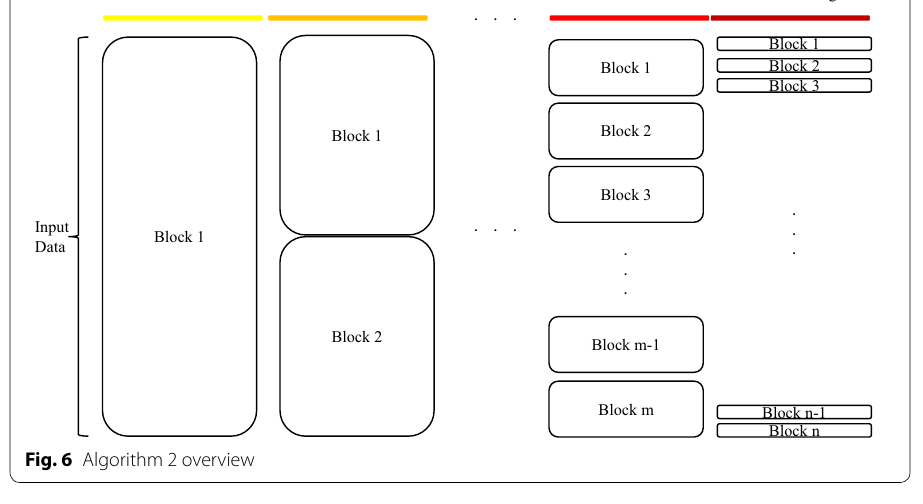
Fig. 6 Algorithm 2 overview